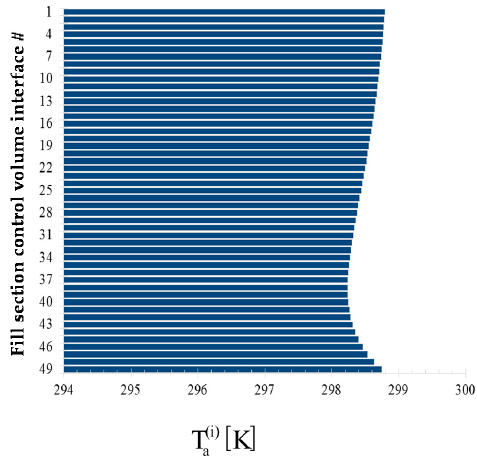
Figure 5. Bar plot of the outlet water temperature ( ) i T along the height of the fill section of the cooling tower.